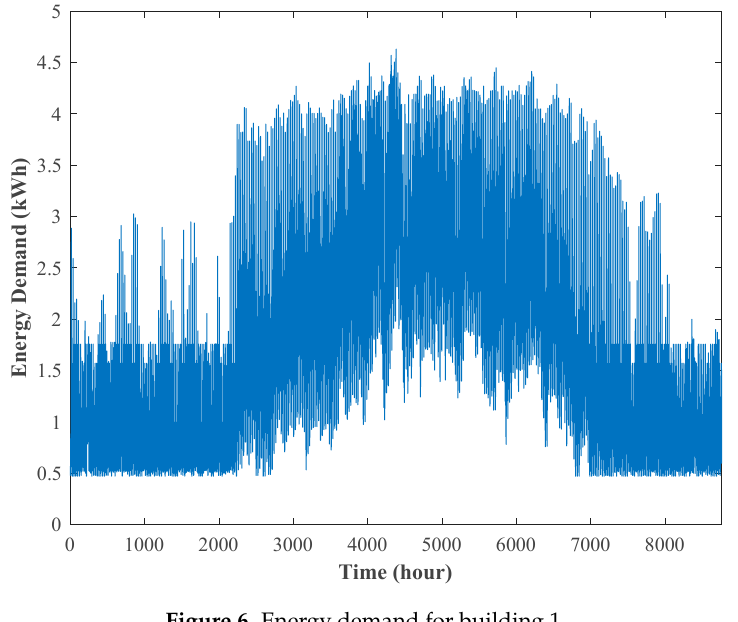
Figure 6. Energy demand for building 1.